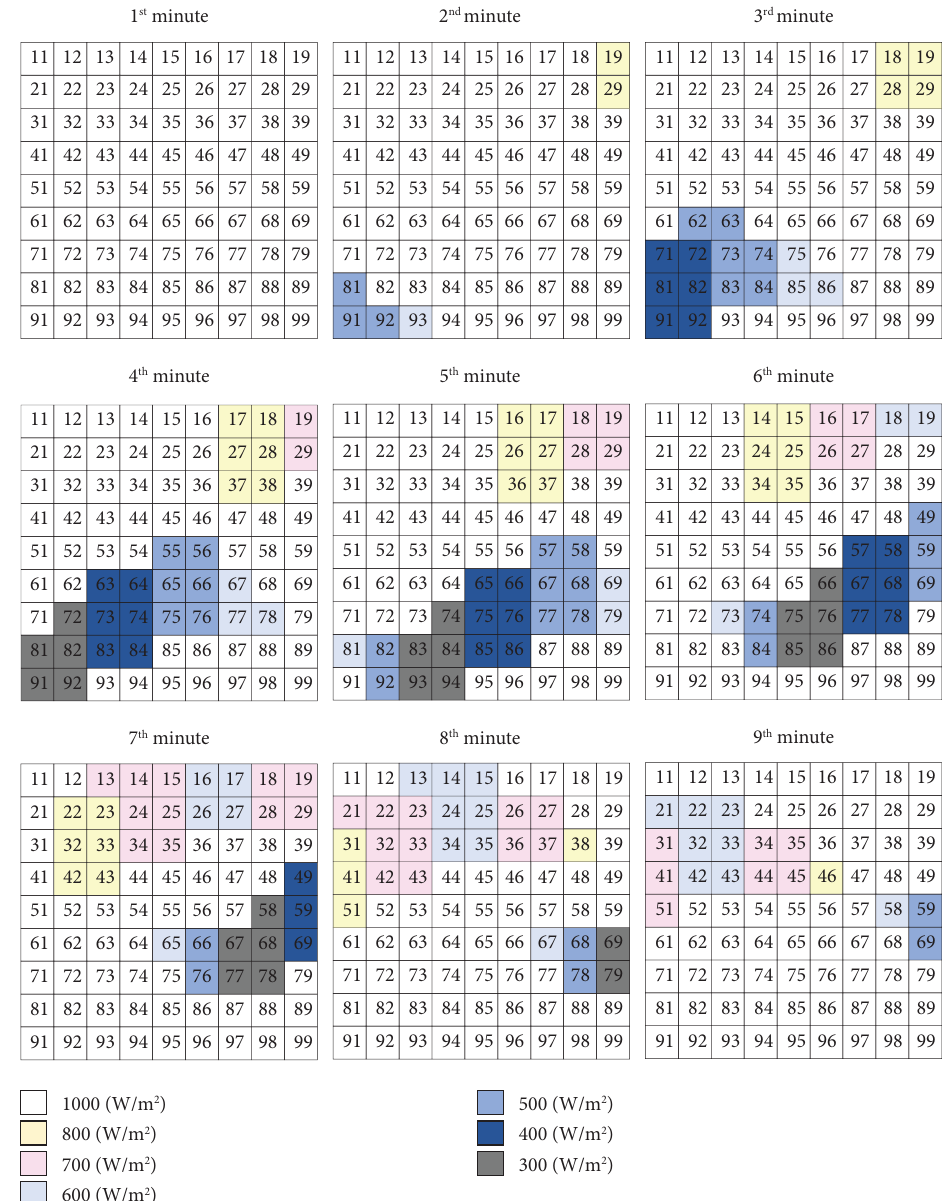
Figure 5: Te irradiation of each PV array in 9minutes under the shadow of moving